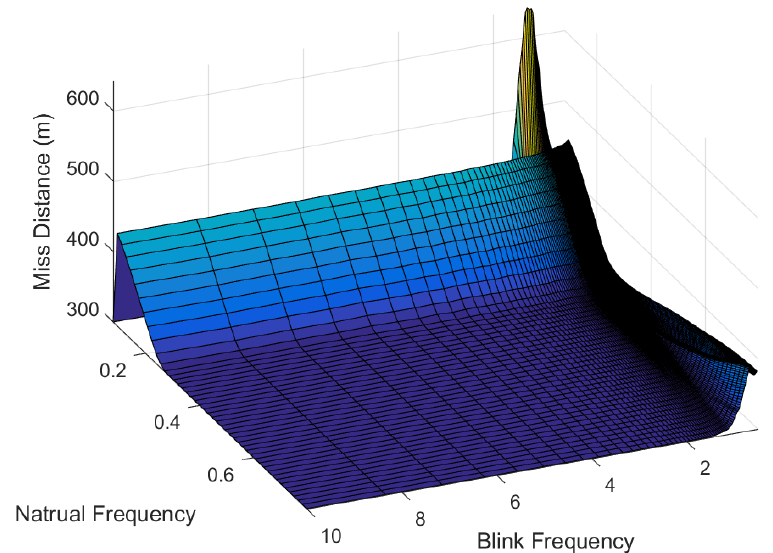
Figure 25. The average miss distance during a set of engagements with varied antenna angle tracking response frequencies and blinking frequencies using a square wave.